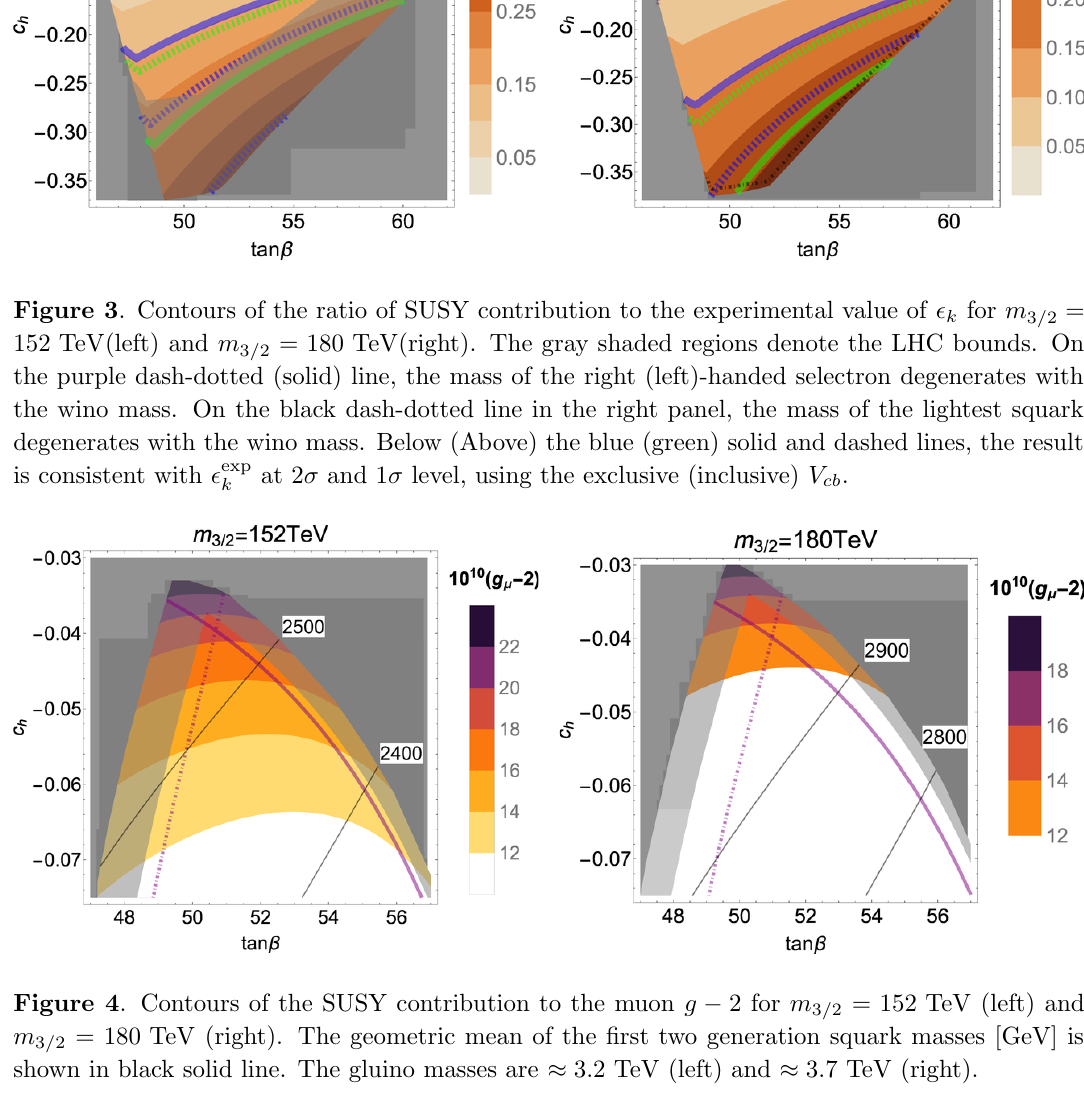
= 152 TeV (left) and 3 = 2